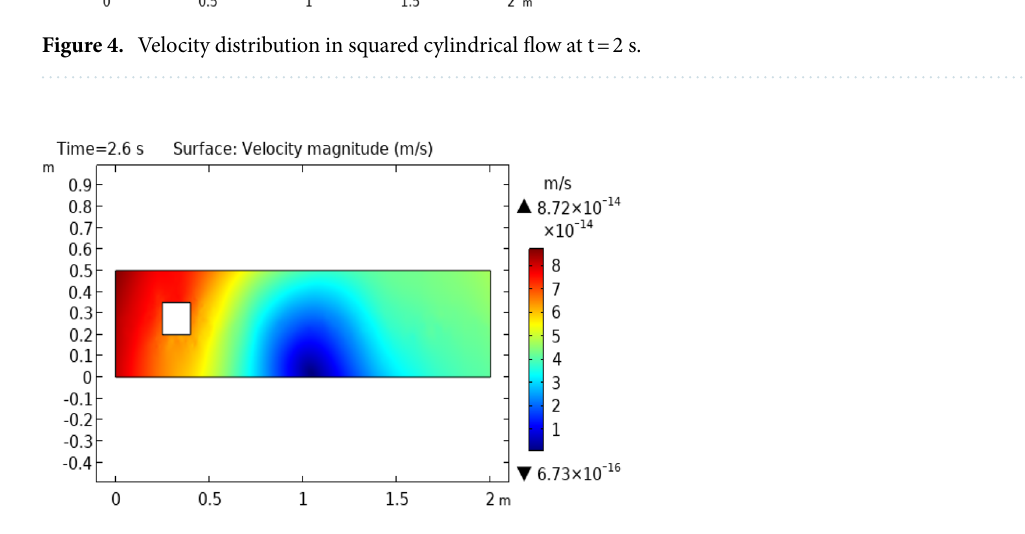
Figure 5. Velocity distribution in squared cylindrical flow at t = 2.6